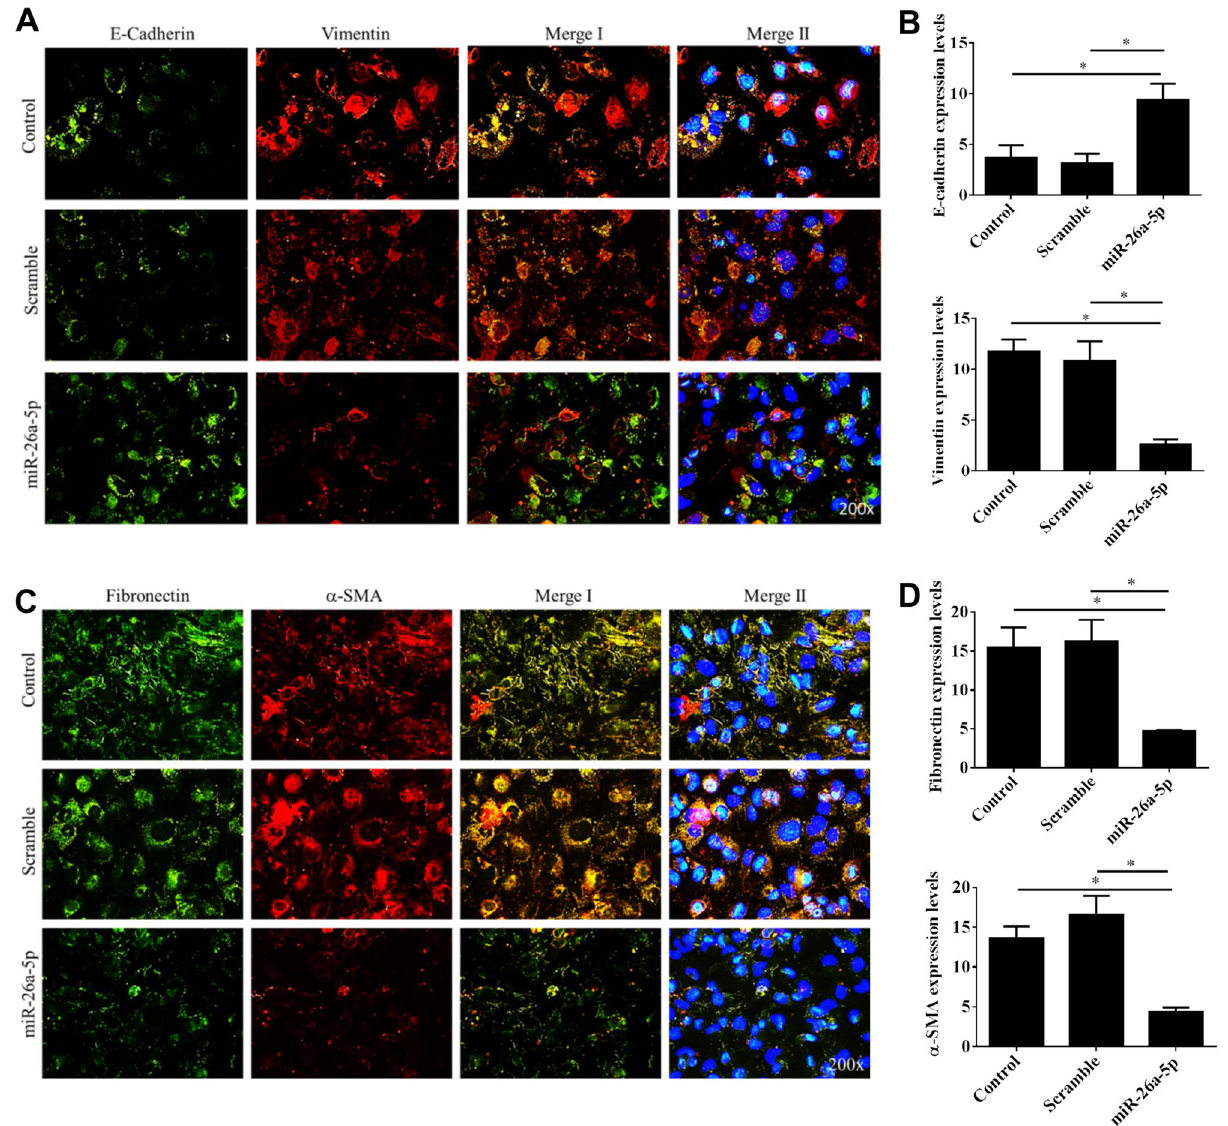
Figure 3. miR-26a-5p overexpression inhibited expression of mesenchymal markers in UTUC cells. BFTC-909 UTUC cells were transfected with miR-26a-5p mimics for 48 h and subjected to immunofluorescent staining. ( A ) Representative images of cellular E-cadherin (green), vimentin (red), and nuclei (blue) were shown. ( C ) Alternatively, cellular fibronectin (green), α-SMA (red), and nuclei (blue) were immunofluorescently visualized. ( B,D ) The fluorescence intensities of epithelial marker E-cadherin as well as mesenchymal markers, vimentin, α-SMA and fibronectin, were quantified by counting 5–10 different fields per sample. Data are expressed as mean ± SEM (n = 3). *Indicates a P < 0.05 between the indicated groups. Original magnification: ×